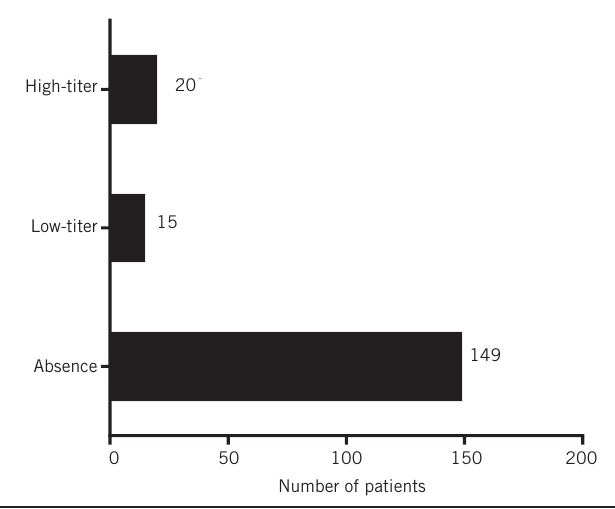
figurE 3 − Presence of the of anti-factor VIII inhibitor antibody